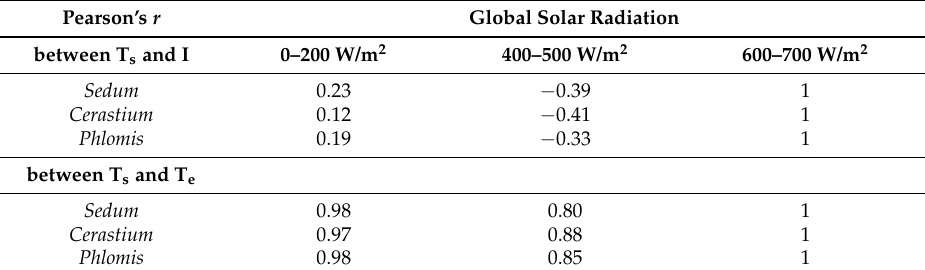
Table 5. The Pearson’s r between (T s ) and (I), and between (T s ) and (T e ), calculated considering three global solar radiation intervals.